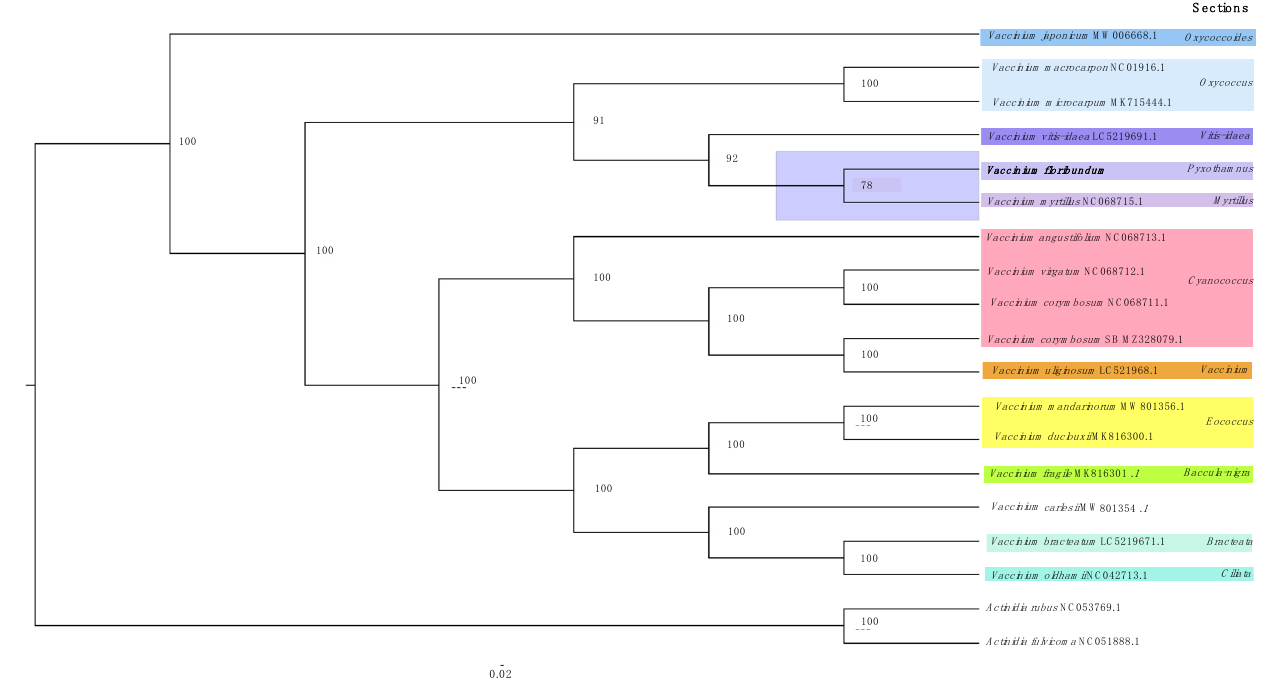
13 of 20 Figure 6. Gene border junction graph of the LSC, SSC, and IR regions in V. floribundum cp genome and the other nine Vaccinium species obtained with IRScope. The numbers with the arrows represent the distance in bp between each junction. Note that the distances are not drawn to scale and that the cp genomes follow the typical quadripartite structure with one LSC, one SSC, and two IR regions. 3.5. Phylogenetic Analysis In order to resolve the phylogenetic relationship of V. floribundum, a maximum like- lihood (ML) tree was constructed using 87 genes (Material S2) from 17 Vaccinium species cp genomes (including V. floribundum ) and two outgroup species (from the Actidinia ge- nus) (Figure 7). The resulting tree was highly resolved, as all nodes had 100% bootstrap support (BS), except for the clade (91%) comprising the sections Oxycoccus (100%), Vitis- idaea (92%), Pyxothamnus, and Myrtillus (78%). Only one member of the Oxycoccoides sec- tion was identified ( V. japonicum ), two for the Oxycoccu s section ( V. macrocarpon and V. microcarpum ), one for the Vitis-idaea section ( V. vitis-idaea ), one for the Pyxothamnus section ( V. floribundum ), one for the Myrtillus section ( V. myrtillus ), four for the Cyanococcus section ( V. angustifolium, V. virgatum, V.corymbosum, V. corymbosum SB), one for the Vaccinium sec-